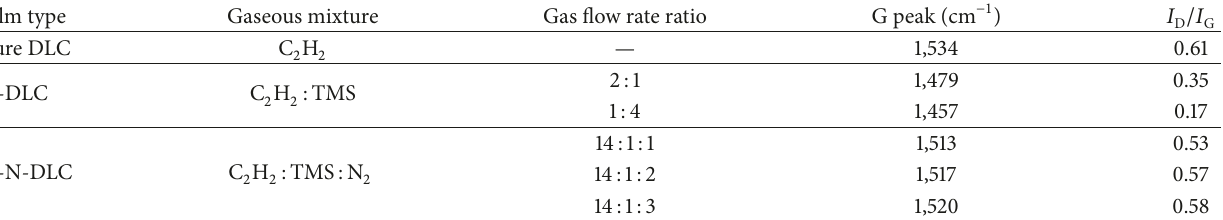
Table 2: G peak and 𝐼 D /𝐼 G intensity ratio for all films.